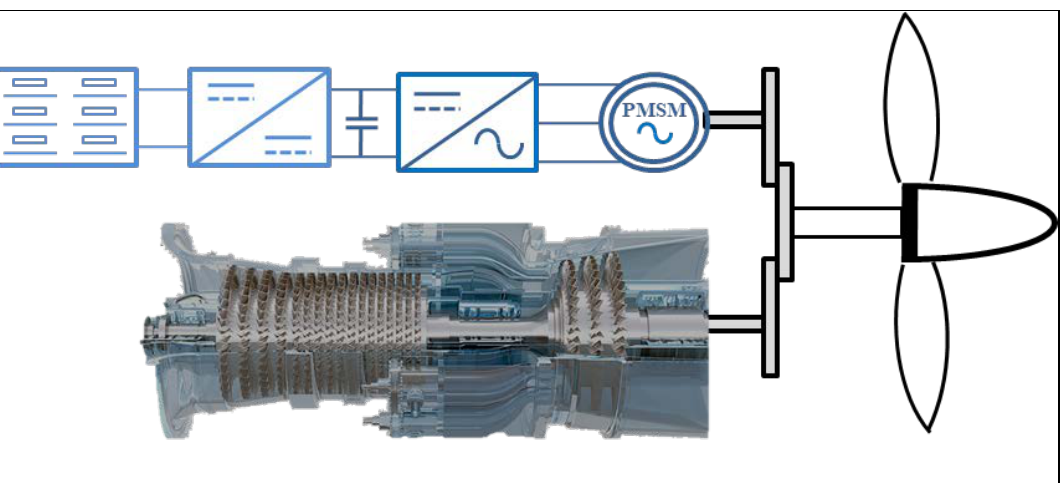
Figure 1. Hybrid parallel configuration.